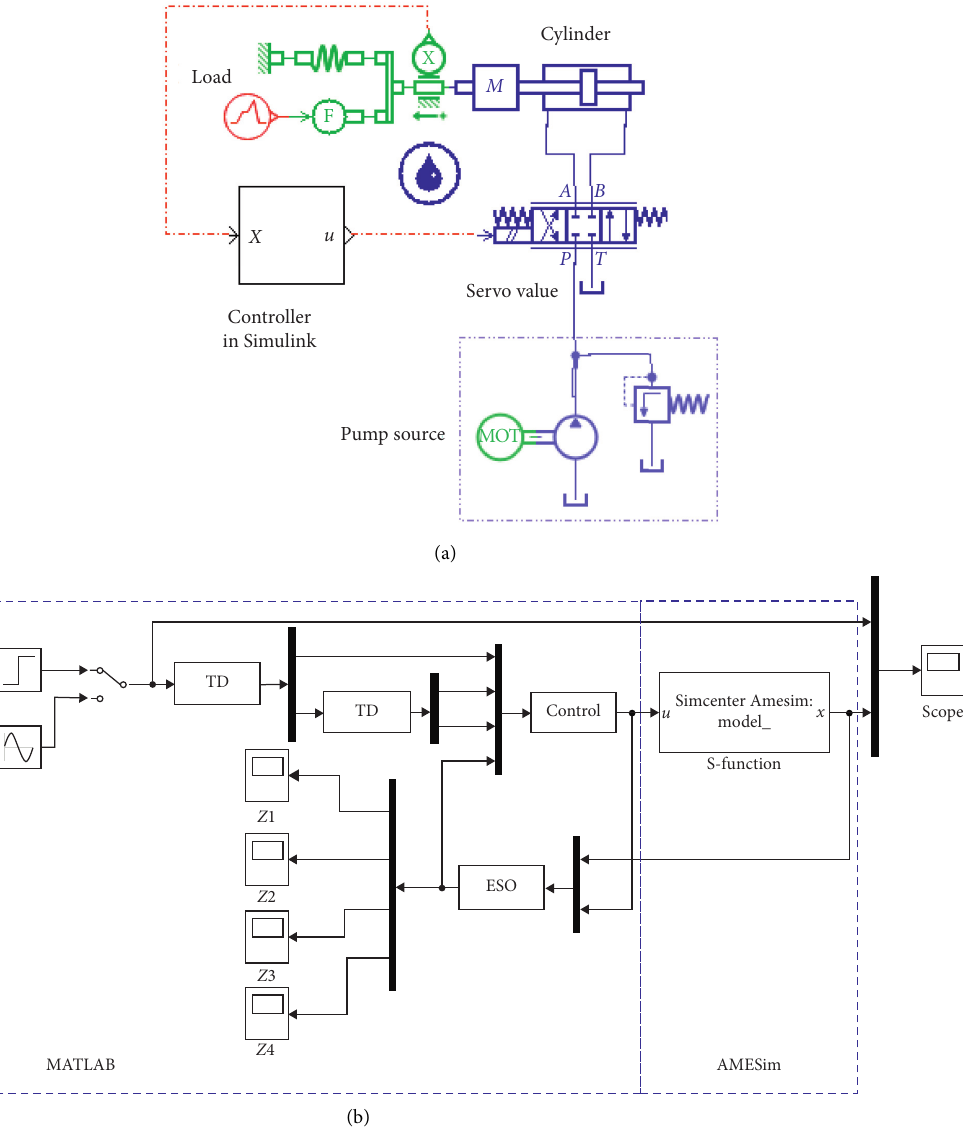
Figure 5: Cosimulation model. (a) Hydraulic system model in AMESim. (b) ADRC model in